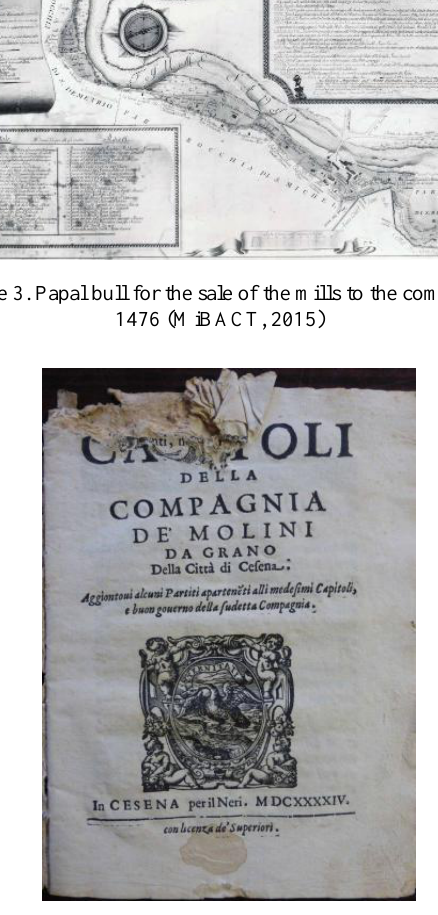
Figure 4. The first page of the mill company’s statute, 1644 (MiBACT,